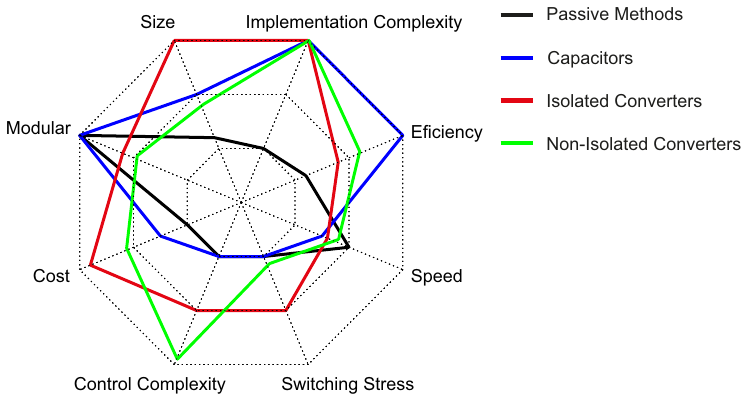
Figure 2. Comparison of balancing methods. Table 1. Comparative table of the main characteristics of the balancing topologies (based on [6,12,18]).